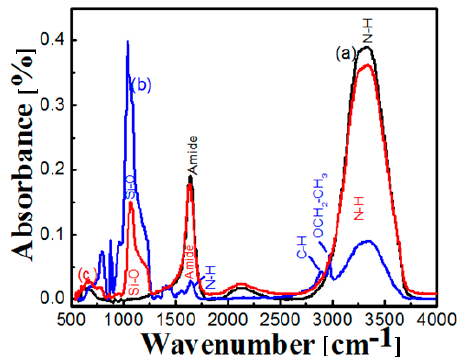
Figure 4. FTIR spectra of (a) Free NPST-AK15 protease enzyme (balck); (b) amino-functionalized hollow core-mesoporous silica (HCMSS–NH 2 ) nanospheres (blue) and (c) NPST-AK15 protease immobilized onto amino-functionalized hollow core-mesoporous silica (HCMSS–NH 2 ) nanospheres (red).